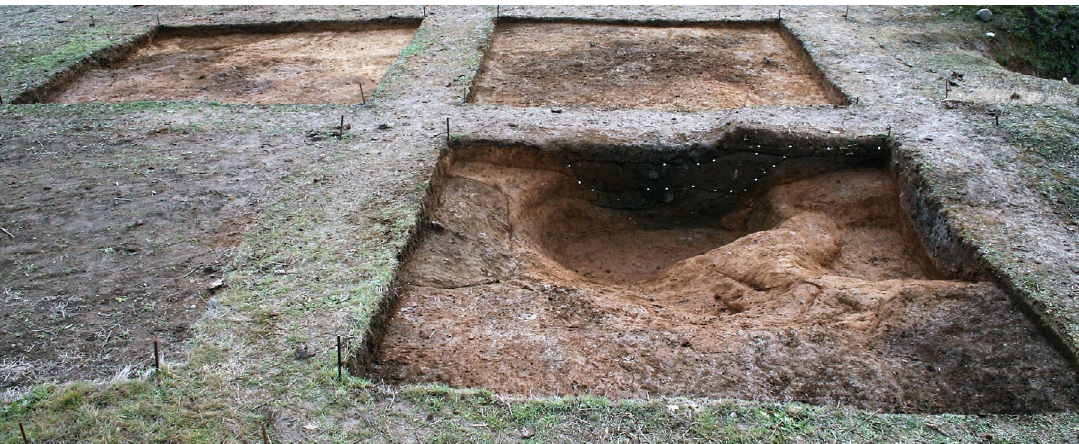
Figure 8. The rescue excavation in 2015 at Idomeni (archive of the Ephorate of Antiquities of Kilkis, photo Stamatis